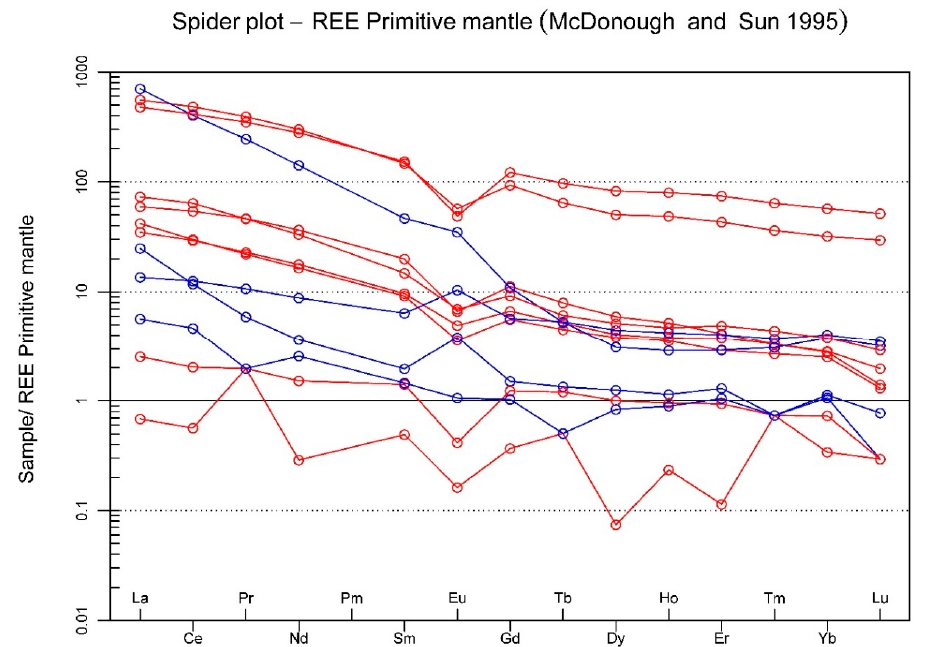
Figure 2. REE spider plot [37] of host rocks from the northern districts; Kiruna mine and occurrences close to this area (red) display a distinct Eu trough and a relative enrichment in LREEs compared to the HREEs, and while the samples from the Malmberget mine and occurrences nearby show extensive metamorphism and deformation overprint compared to the Kiruna area (Blue). Data sources: SGU and